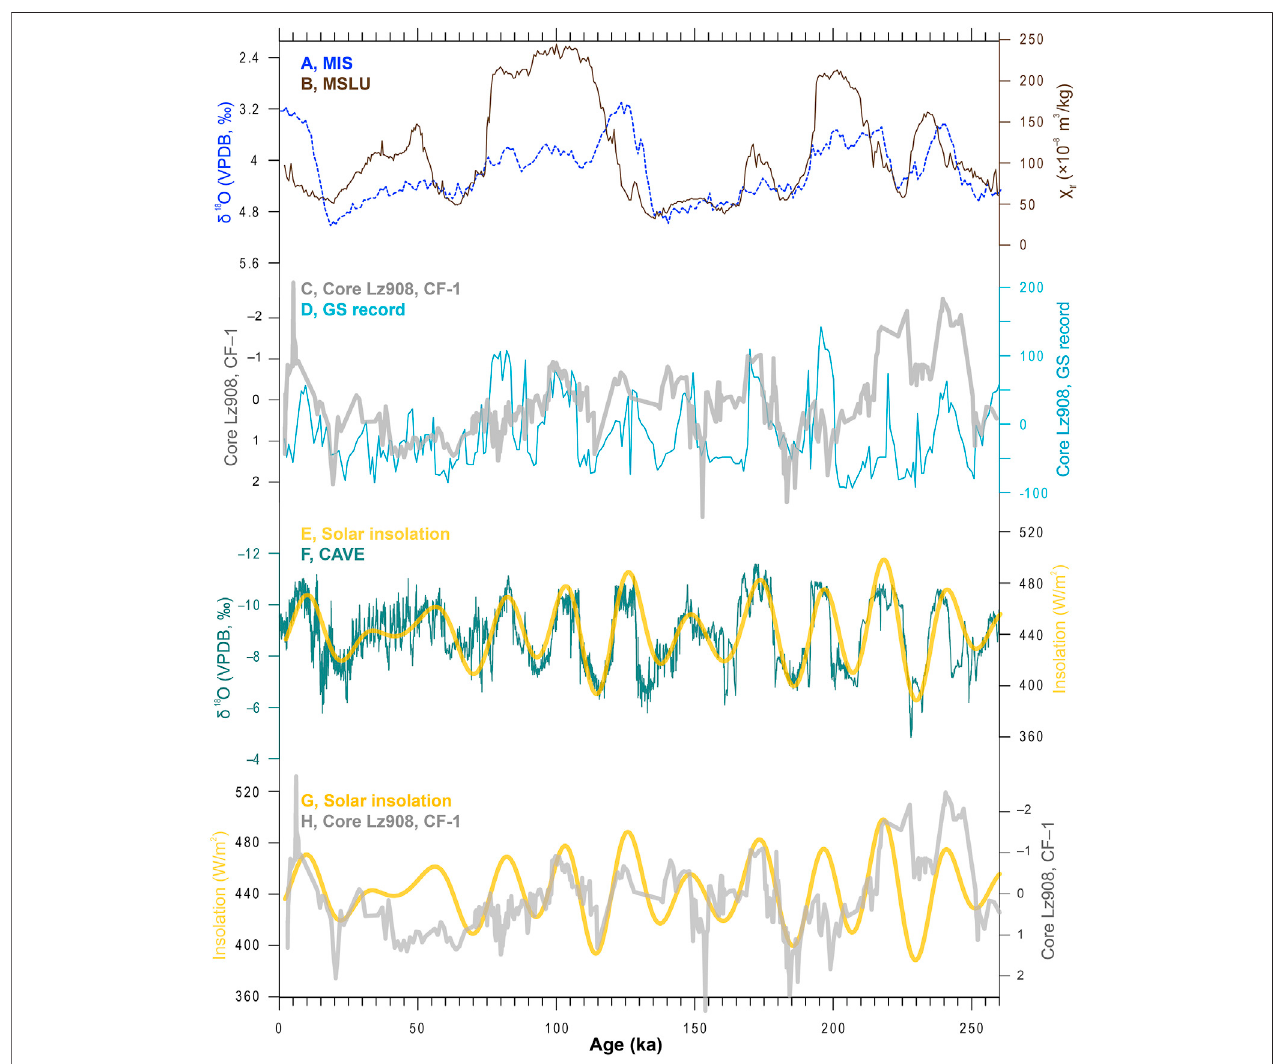
FIGURE 6 | Comparisons between EASM proxies in the late Quaternary. (A) MIS record of deep – sea sediment δ 18 O (Lisiecki and Raymo, 2005); (B) MSLU, magnetic susceptibility recordoftheLuochuanpro fi le (Luand An, 1997); (C – D) CF – 1and GSrecordsofcore Lz908(this study); (E) INS (solar insolation),Julyinsolation at 65 ° N (Berger and Loutre, 1991); (F) CAVE, stalagmite δ 18 O series (Cheng et al., 2016). The used datasets were from Figure 5 .